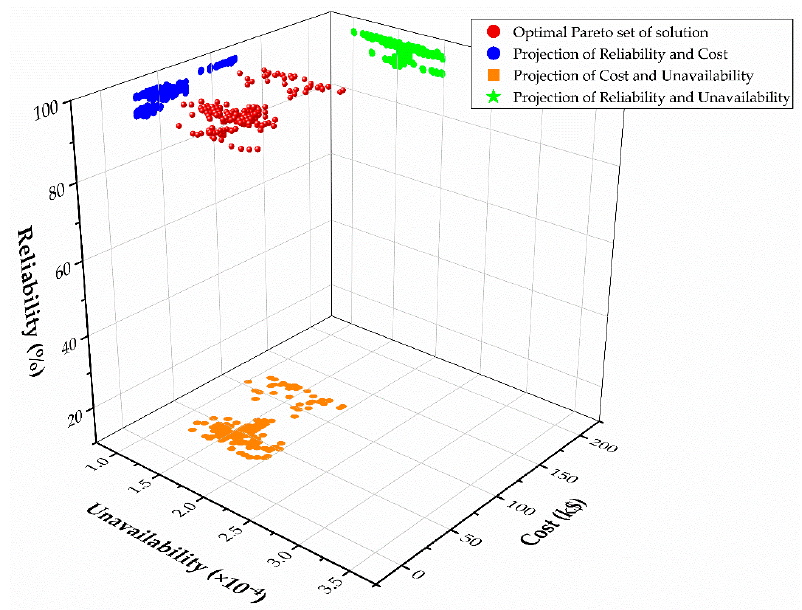
Figure 8. The final set of Pareto optimal solutions.